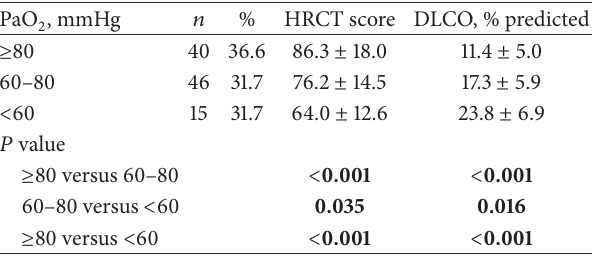
Table 4: Comparison of HRCT score and lung function values between different groups according to PaO 2